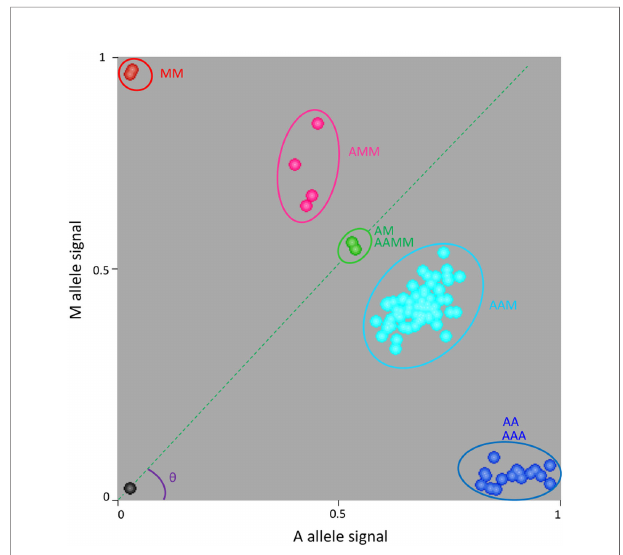
FIGURE 2 | Example of genotype calling for the S03_46198875 SNP marker using KlusterCaller software and inference of allele dosage for triploid hybrids. M is the speci fi c allele of C. micrantha and A is the alternative one. AA and MM, homozygous accessions; AM and AAMM, ‘ Mexican ’ lime and ‘ Giant key ’ lime respectively; AAM, triploid hybrids with one dose of C. micrantha ; AMM, triploid hybrids with two doses of C. micrantha ; AAA, triploid hybrids with no dose of C. micrantha